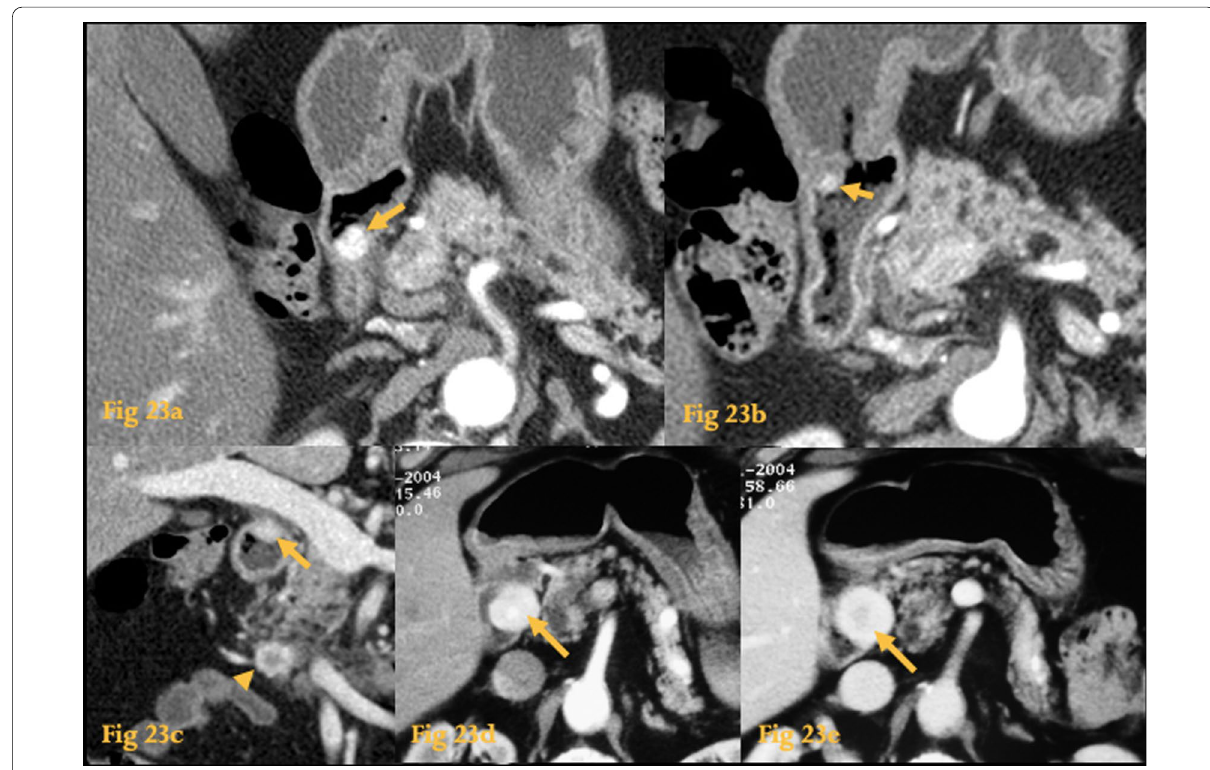
Fig. 23 Neuroendocrine tumor. Arterial phase CT ( a , b ) of a patient with type I multiple endocrine neoplasia, with hypergastrinemia, shows two small hypervascular nodular lesions on the wall of D2 and D1 (arrows). Coronal reformation ( c ) better shows the duodenal bulb lesion (arrow) and another similar lesion at the pancreatic head (arrowhead). Histopathological study following pancreatoduodenectomy revealed duodenal and pancreatic neuroendocrine tumors (gastrinomas). Abdominal CT of another patient shows a mass (arrows) in the medial wall of D2 with intense contrast enhancement in the arterial phase ( d ) and venous phase ( e ) of the dynamic study. The high spatial resolution provided by CT clearly shows that the lesion is independent from the